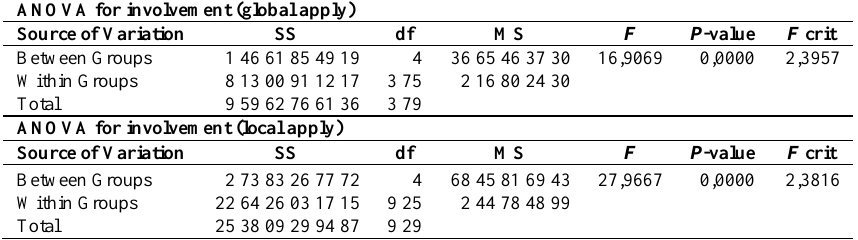
Table 5. ANOVA for involvement ANOVA for involvement (global apply) Source of Variation